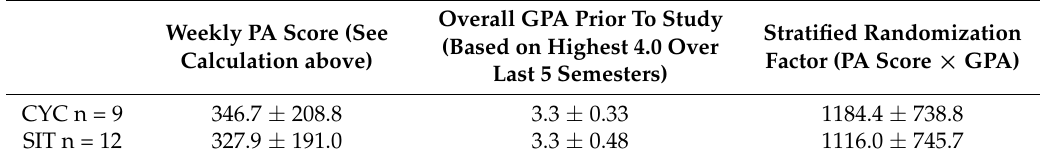
Table 1. Stratified randomization process for equally-match groups. Participant reported physical activity (PA) score (aerobic duration min/week × intensity (1 = low, 2 = moderate, 3 = high) × frequency (times per week) + estimated resistance training min/week and grade point average (GPA) (mean ± SD) for SIT and CYC groups.